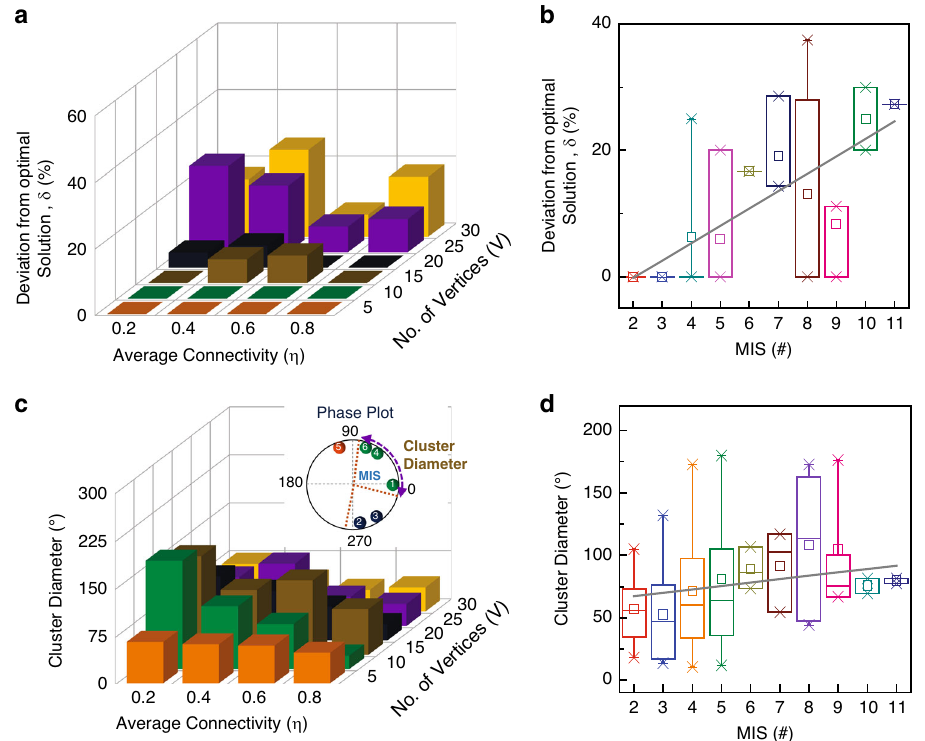
Fig. 3 Computational characteristics of the coupled oscillators. a Effect of graph size ( V ) and connectivity ( η ) on the quality of measured MIS solution (expressed as a deviation ( δ ) from the optimal solution). b Impact of the MIS size on the observed deviation. The quality of the solution computed by the oscillators is a strong function of the MIS size. c Evolution of cluster diameter of the MIS vertices as a function of V and η . d Effect of MIS size on the cluster diameter. The cluster diameter increases with the size of the MIS. Box plot results in b , d : center: median; box: interquartile range (IQR); whiskers: 1.5×